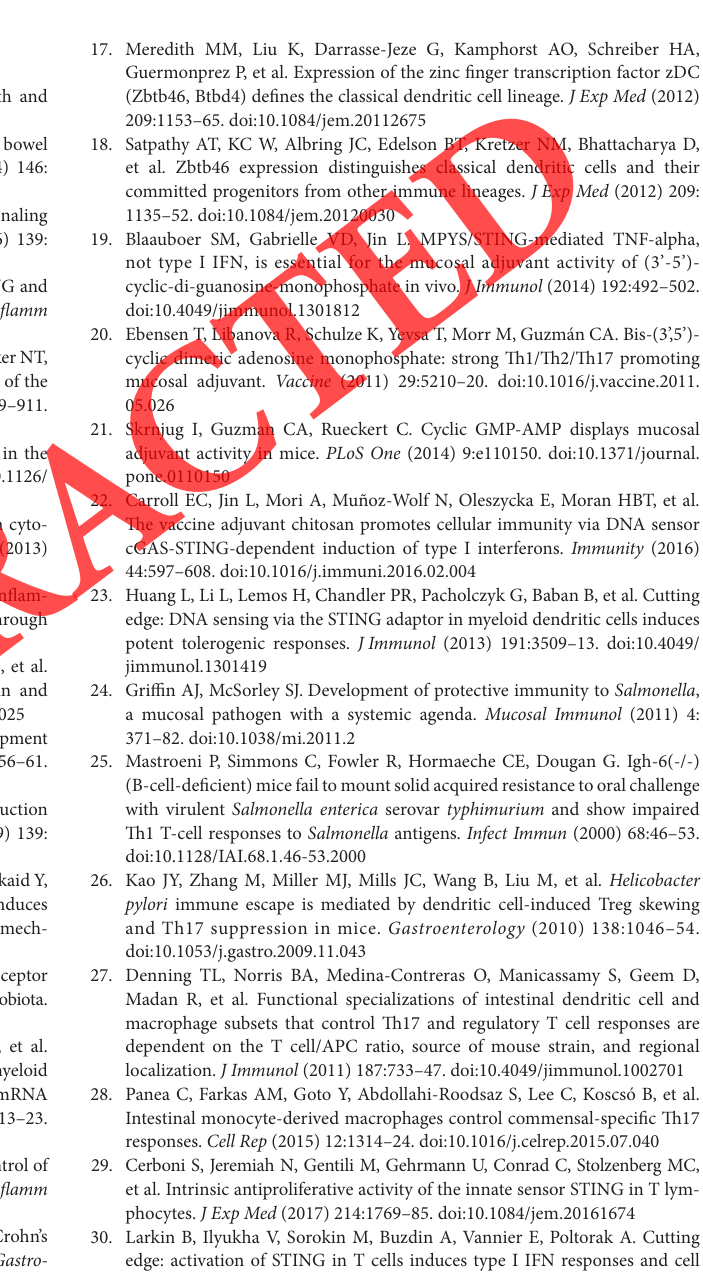
FigUre s3 | Cytokine expression of Tmem173 -deficient pDCs in response to cyclic dinucleotides. Fold change of Il6 , Ifnb1 , Tnf , Il1b , Il10 , Il23a , and Tgfb1 gene expression in plasmacytoid DCs (pDCs) of Tmem173 − / − mice in response to cyclic dinucleotides. C57BL/6 and Tmem173 − / − mice were injected (i.p.) with PBS or c-di-GMP at day − 1, − 3, and − 5, and pDCs were then isolated from small intestine lamina propria ( n = 4). FigUre s4 | Ex vivo analysis of cytokine expression by plasmacytoid DCs (pDCs) in response to cyclic dinucleotides. Fold change of Ifnb1 , Il6 , Il1b , Tnf , Il10 , Il23a , and Tgfb1 gene expression in pDCs from small intestinal lamina propria in response to cyclic dinucleotides. PBS or c-di-GMP was injected (i.p.) before sacrifice ( n = 5). FigUre s5 | Lamina propria DCs separation strategy during Salmonella infection by flow cytometry. Cells from small intestine lamina propria